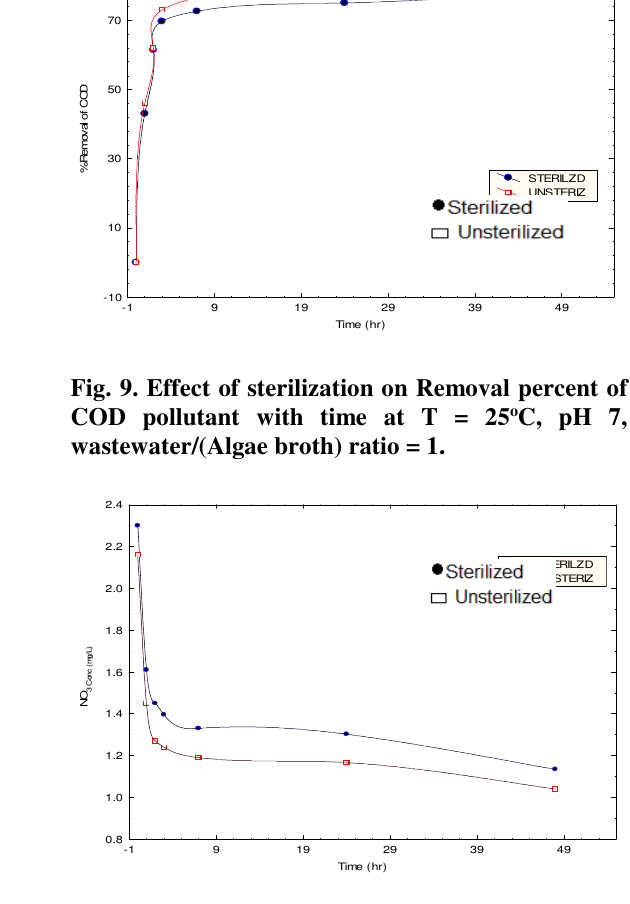
Fig. 10. Effect of sterilization on the concentration level of NO 3 pollutant with time at T=25 o C, pH 7, wastewater/ (Algae broth) ratio